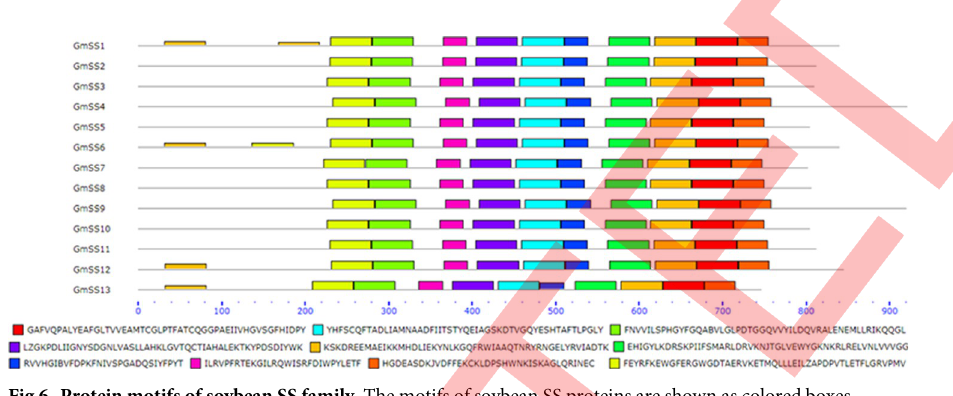
Fig 6. Protein motifs of soybean SS family. The motifs of soybean SS proteins are shown as colored boxes.